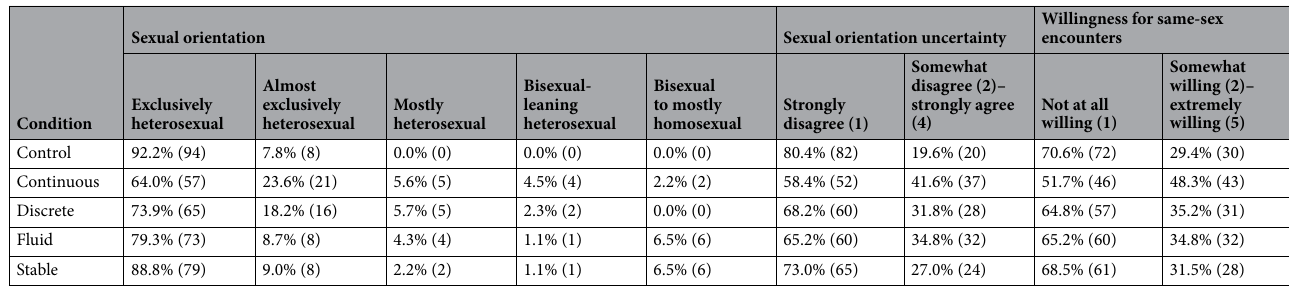
Table 5. Study 2. Post-manipulation ratings of sexual orientation, sexual orientation uncertainty and willingness for same-sex encounters in control, continuous, discrete, fluid, and stable